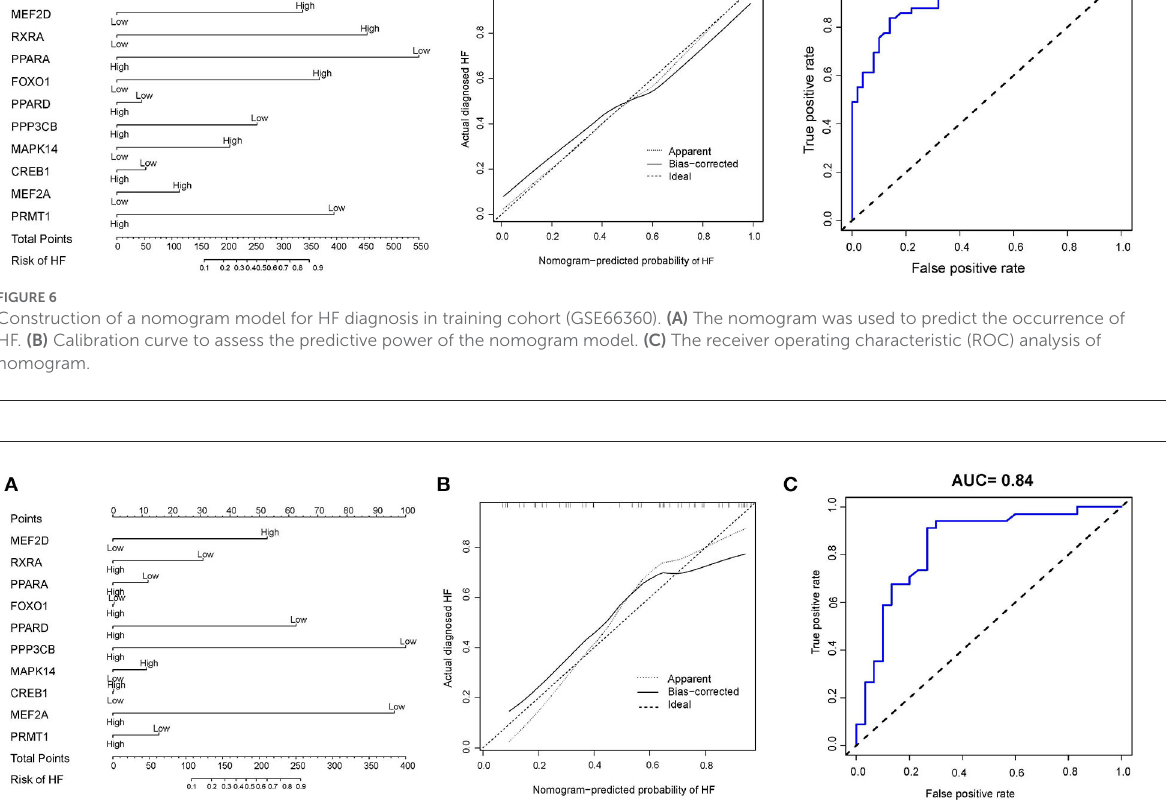
FIGURE7 Construction of a nomogram model for HF diagnosis in test cohort (GSE59867). (A) The nomogram was used to predict the occurrence of HF. (B) Calibration curve to assess the predictive power of the nomogram model. (C) The receiver operating characteristic (ROC) analysis of